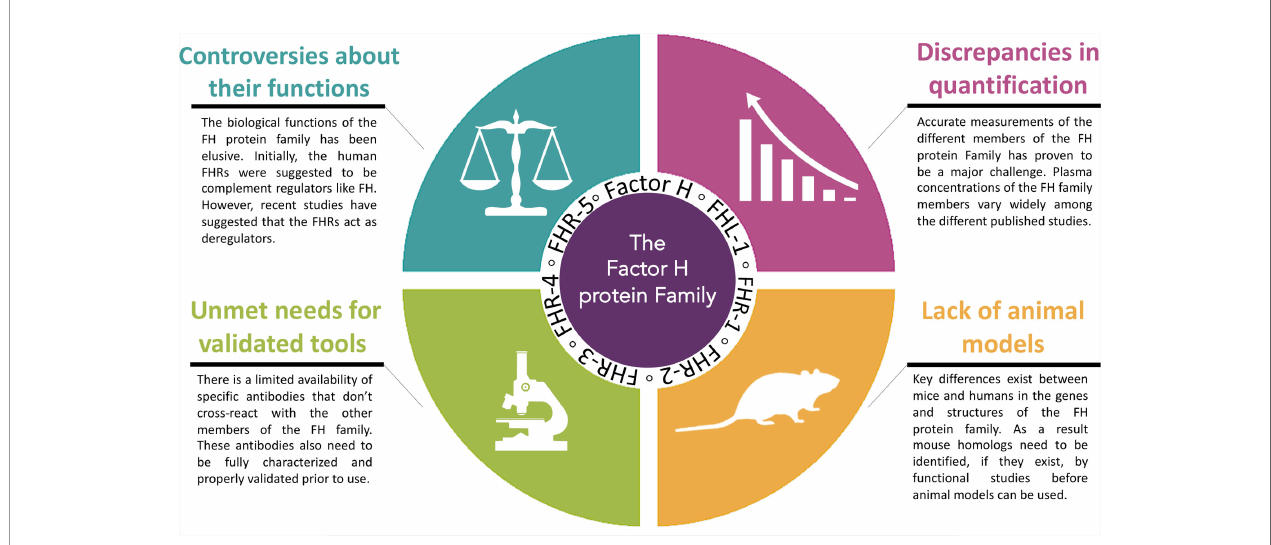
FIGURE 1 | Four speci fi c unmet challenges for the Factor H protein Family. The major challenges ahead in this emerging area are: 1. the controversies about the functional roles of the Factor H protein family, 2. the discrepancies in quanti fi cation of the Factor H protein family, 3. the unmet needs for validated tools and 4. limitations of animal